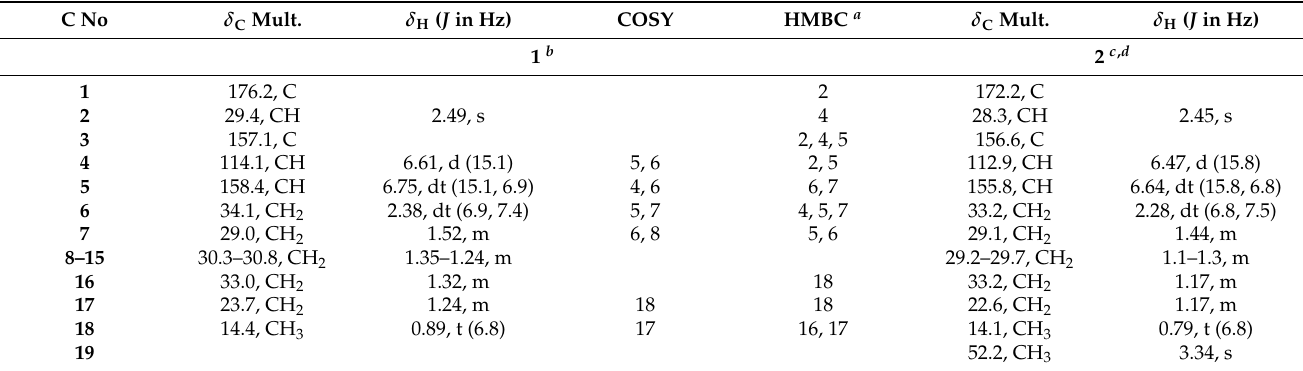
NMR spectroscopic data for (4 E )- R -dysidazirine carboxylic acid ( 1 ) and (4 E )- R - dysidazirine ( 2